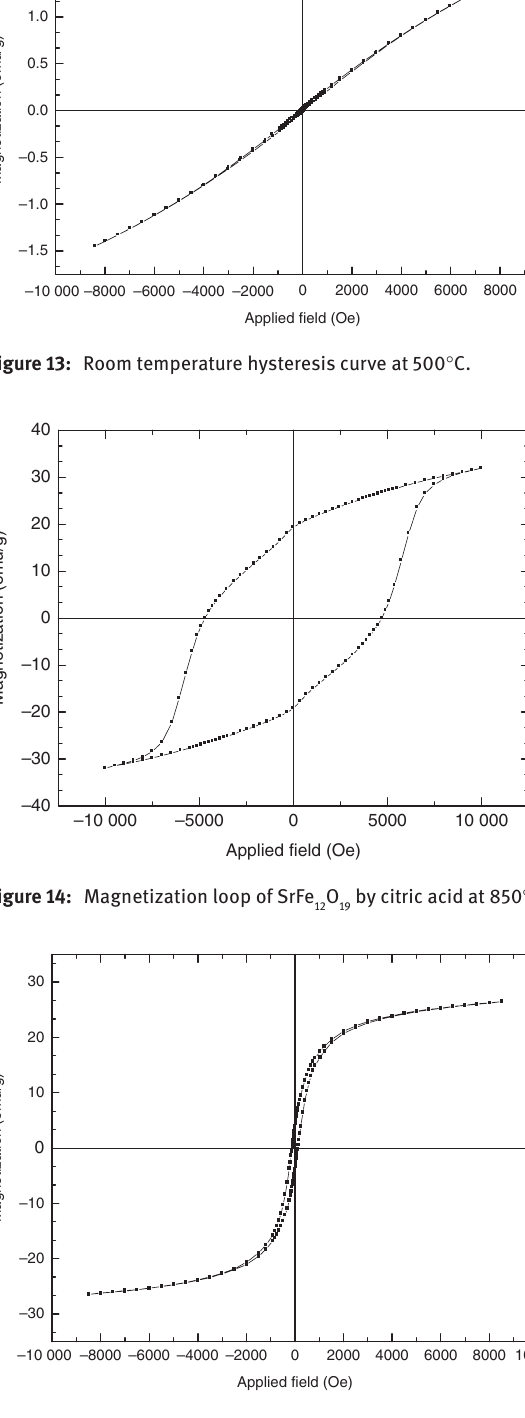
Figure 15: Hysteresis loop of product obtained with citric acid-EG at 500 ° C.